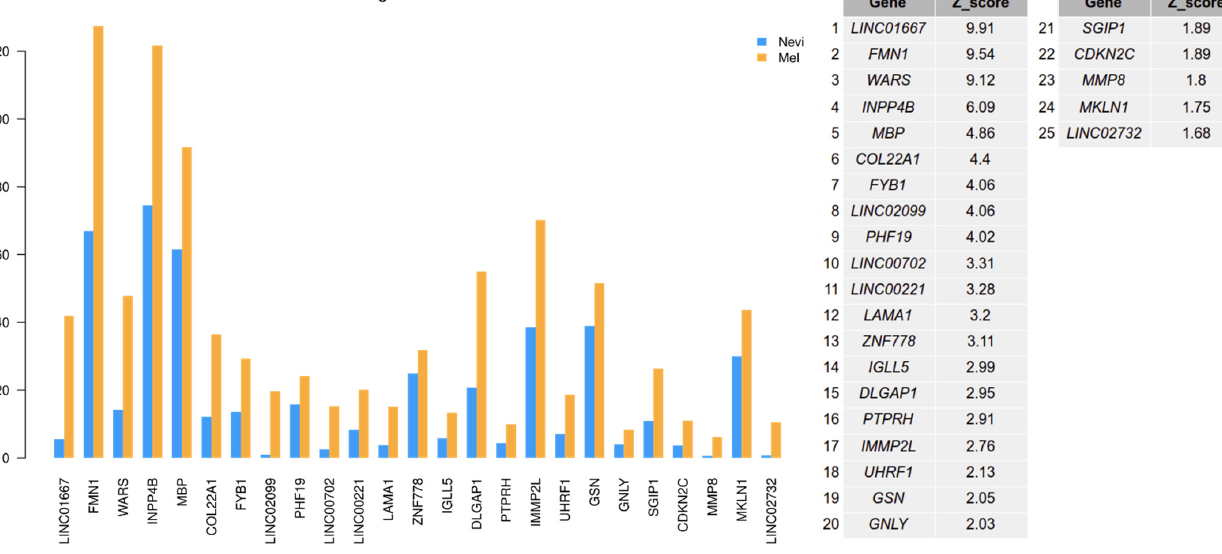
Figure 7. Number of coding mutations by gene in melanomas compared to benign melanocytic nevi. A mutation analysis was performed from the basic set of samples sequenced by RNA-seq for coding regions of genes. Only mutated genes of switched isoforms above a significance score (Z-score) of 1.6 with a 90% confidence interval are shown. Laminin Subunit Alpha 1 ( LAMA1 ) was detected as the top gene on the list for spliced genes with coding mutations. LAMA1 encodes the alpha 1 subunit of laminin. Laminins are extracellular matrix glycoproteins that make up a major component of the basement membrane and have been implicated in cell adhesion, migration, signaling, and tumor metastasis [41,42]. Another gene, Formyl Peptide Receptor 1 ( FPR1 ), is normally ex- pressed by phagocytic cells and is involved in host defense and inflammation. This pro- tein has also been shown to be involved in melanoma cell migration [43]. Thus, mutated genes found in this analysis may have an impact on melanoma biology, affecting cell mi- gration.